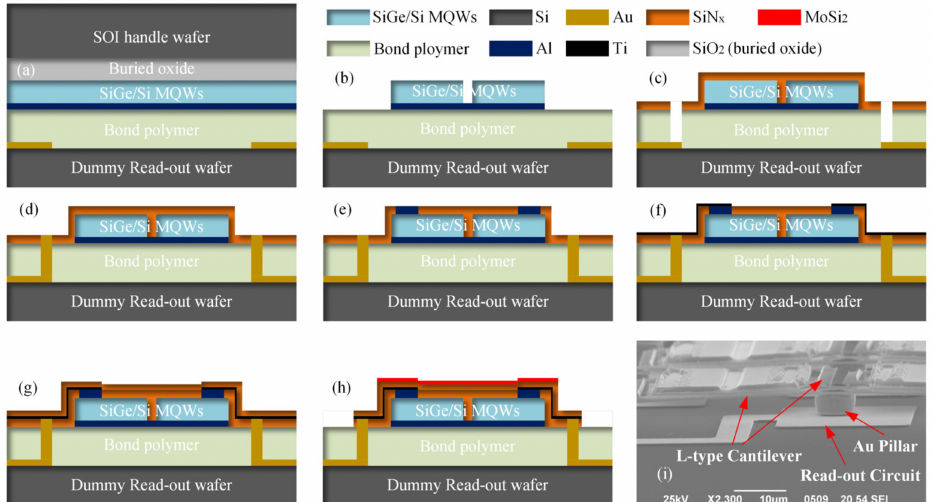
Figure 5. Micro-bolometer fabrication process: ( a ) The heterogeneous integration; ( b ) The SiGe/Si MQWs thermistor defined; ( c ) The SiN x layer deposited and the etched via-holes; ( d ) The Au pillar electroplate; ( e ) The Al contact pads that were defined; ( f ) The patterned Ti connect layer; ( g ) The deposited SiN x layer; ( h ) The deposited MoSi 2 layer and the defined pixel; ( i ) The final